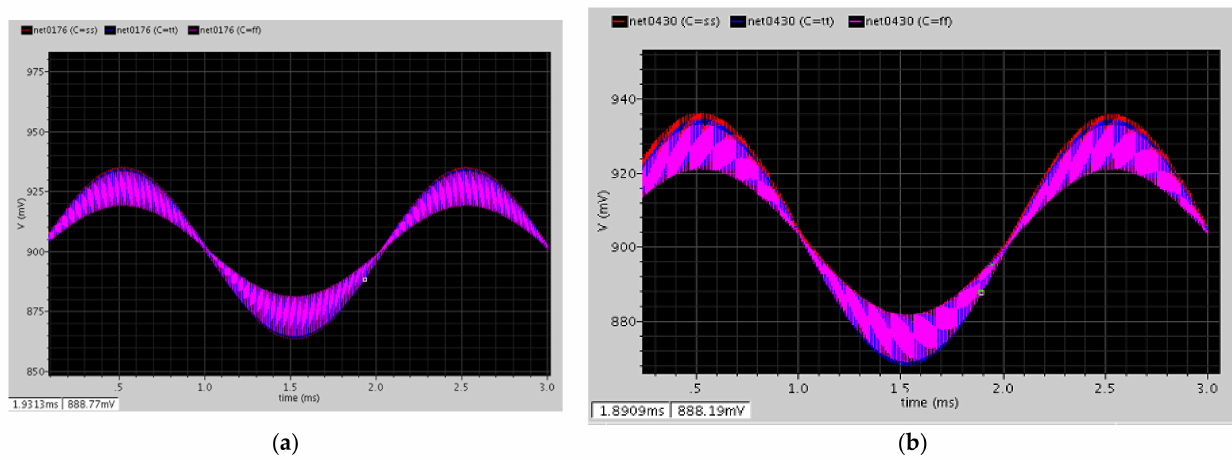
Figure 19. ( a ) After the correlated double-sampling (CDS) demodulation circuit; ( b ) after the buffer